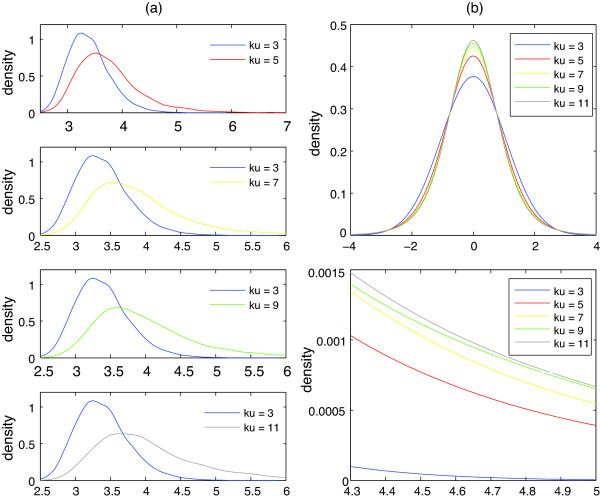
Tail effect on maximal-t distribution. (a) The kernel smoothing density of the maximal-t statistics derived from 10,000 datasets drawn from the Pearson system (Eq.(2)) with skewness = 0 and various kurtosis. Each dataset contained 250 random numbers. (b) The smoothed probability density functions (PDFs) of the Pearson system with skewness = 0 and various kurtosis. The bottom of Figure 2b illustrates the heaviness of right tails for various kurtosis.